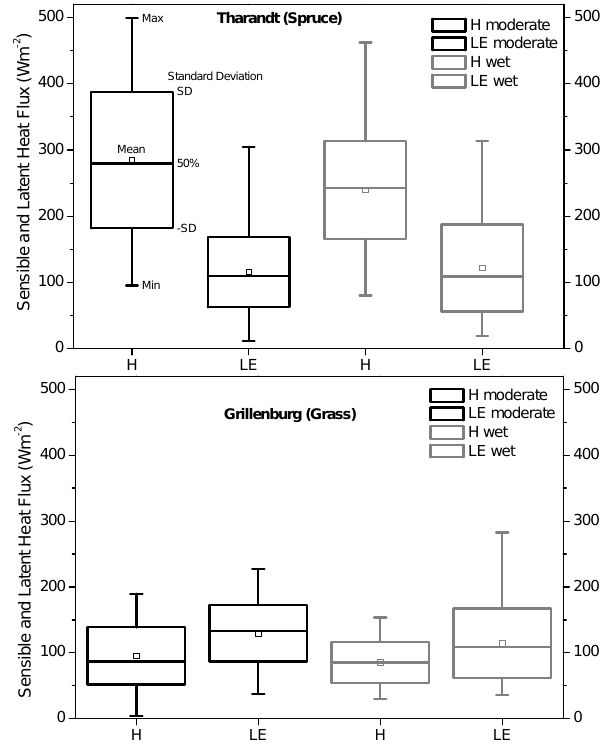
Fig. 2. Measurements (box plots of half hour means) of sensible (H) and latent heat fluxes (LE) at the Anchor Stations Tharandt (spruce, panel above) and Grillenburg (grass, panel below) dur- ing the summer season 2007. The data was filtered for solar ra- diation > 400W/m 2 , high wind speed (friction velocity u ∗ > 0.4m/s for grass and u ∗ > 0.8m/s for spruce), as well as for moderate (soil water content SWC < 30% for grass and SWC < 10% for spruce) and wet soil conditions (SWC > 40% for grass and SWC > 20% for